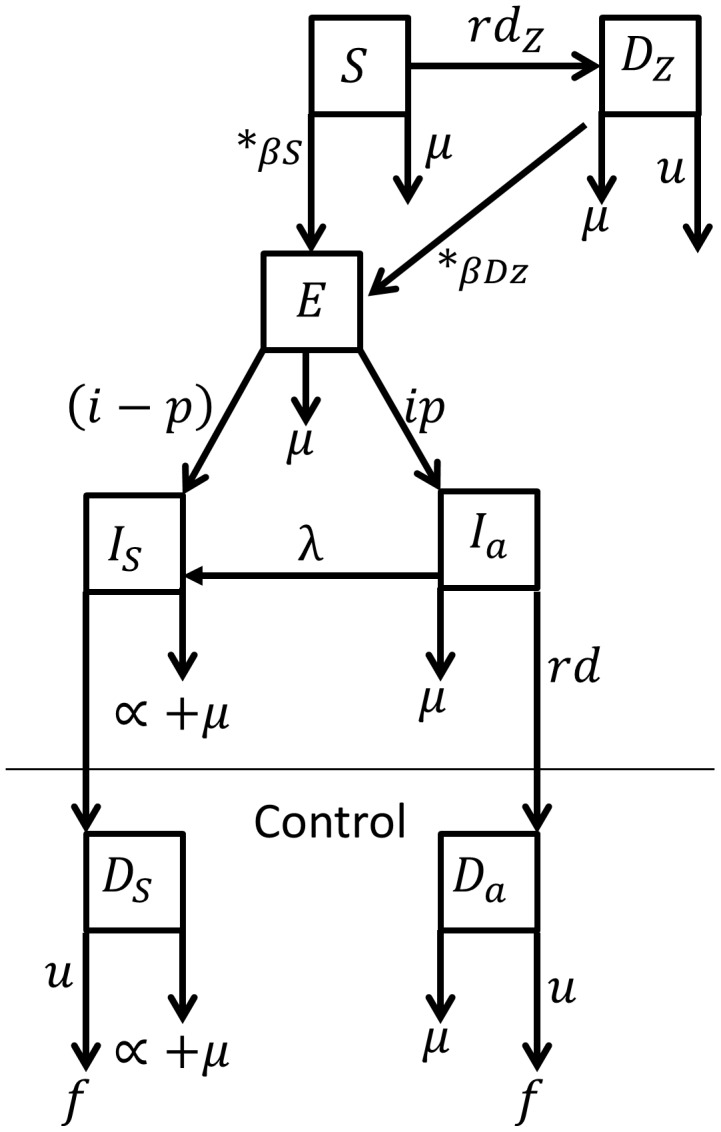
The Canine Leishmaniasis model (SEI2D).All dogs are born susceptible (S), and become infected at a rate ßS. Infected dogs go through a latent stage, after which a fraction evolves to an asymptomatic infection (Ia) while the remaining (1-p) evolve into the symptomatic state (Is). A small fraction of asymptomatic dogs may evolve to present signs of clinical disease, which is incorporated into the model through a relapse rate “λ”. The control program screens animals and, if laboratory positive, they move to class Da or Ds, where they remain until culling. Dz class holds those erroneously classified as positive.